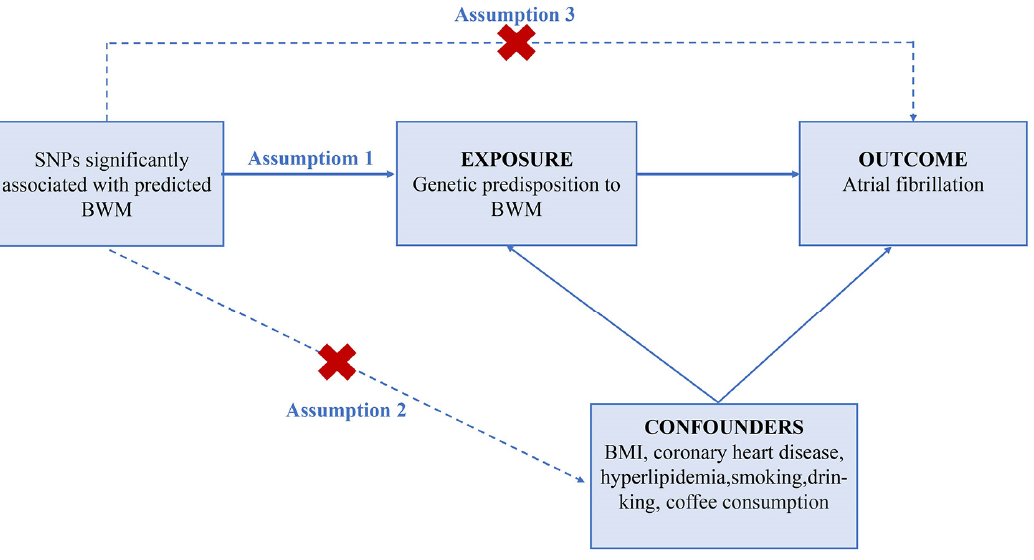
Figure 2. Three imperative assumptions of Mendelian randomization approach. SNP, single- nucleotide polymorphism; BWM, body water mass; BMI, body mass index.